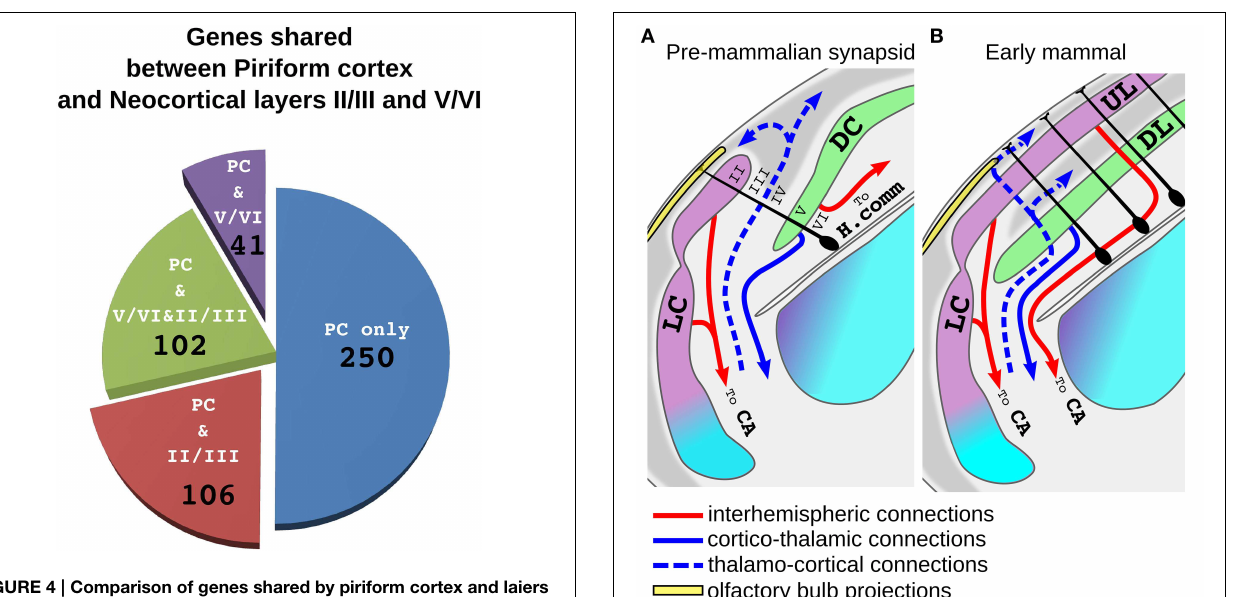
FIGURE 4 | Comparison of genes shared by piriform cortex and laiers II/III or V/VI of the neocortex. The pie chart represents the 500 genes enriched in the piriform cortex. Each sector indicate the number of genes shared only with layers V/VI (violet), only with layer II/III (red) or with both layer II/III and V/VI (green). The fraction of genes that are not enriched neither in layer II/III nor in layer V/VI are in blue.